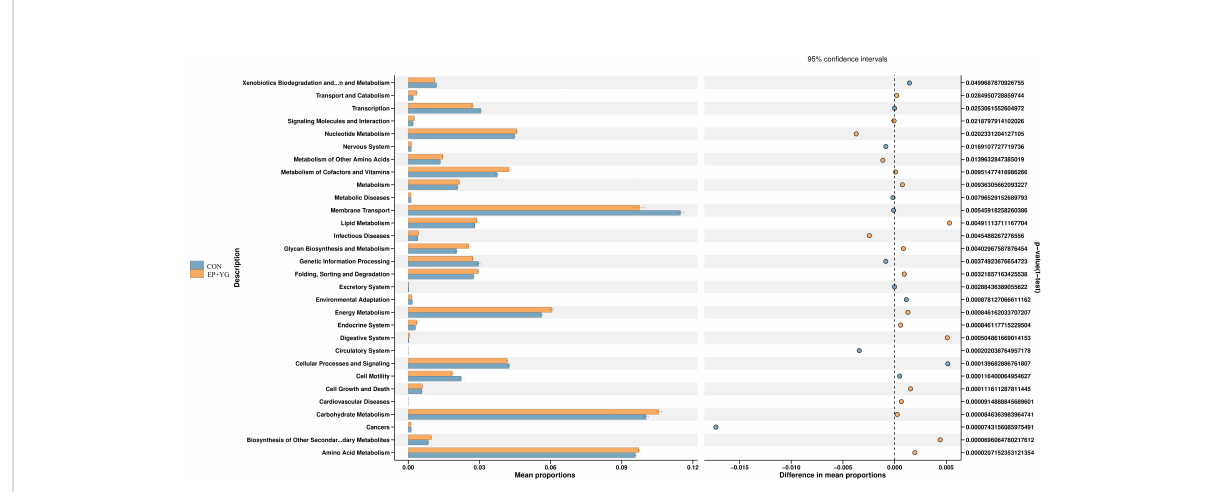
FIGURE 7 Predictive functional analysis of caecal microbiota in the EP+YG treated and control broiler chickens. Predictive functional analysis was conducted using PICRUSt at the second level of the KEGG pathway. CON (fed basal diet); EP+YG (supplemented with 200 mg EP and 200 mg YG/kg diet in